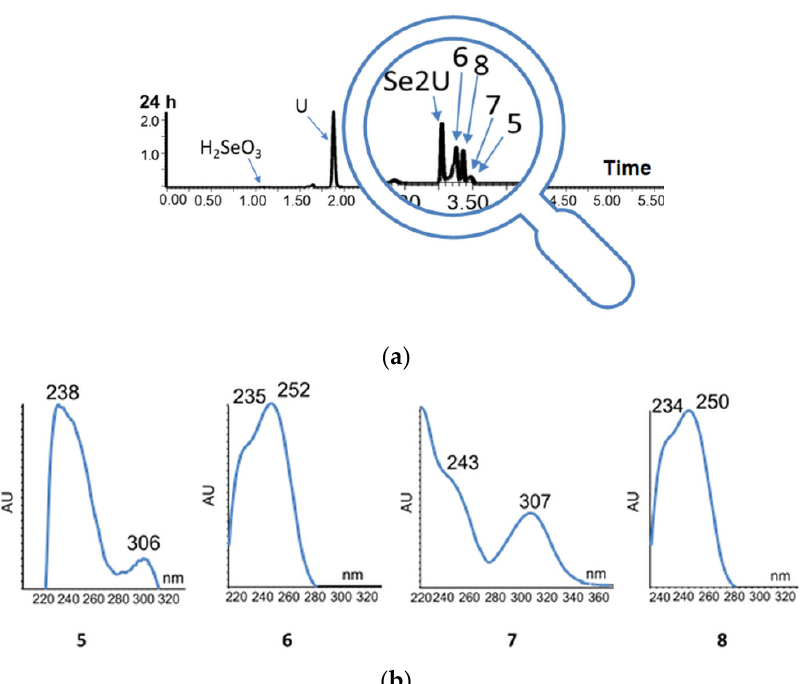
Figure 7. ( a ) UPLC–PDA chromatographic analysis of the oxidation reaction of Se2U ( 1 , 10 mM) with H 2 O 2 (10 mM) in 50 mM phosphate buffer at pH 7.4 and rt. (#1); ( b ) absorption spectra of dinucleosides 5 , 6 and trinucleosides 7 , 8 .